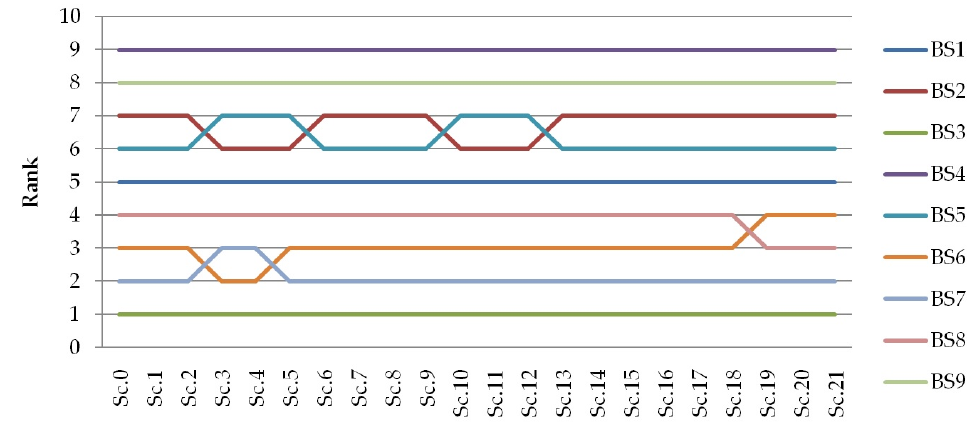
Figure 5. Sensitivity analysis. Based on the results of the sensitivity analysis, it can be seen that in all scenarios, the ranking of BS3 (ranked first), BS1 (ranked fifth), BS9 (ranked eighth) and BS4 (ranked ninth) were unchanged. Other BSs slightly changed their rank throughout the scenarios. BS7 ranked second in all scenarios except in Sc.3 and Sc.4. BS6 ranked third in most sce- narios. It changed rank to second in Sc.3 and Sc.4 and to fourth in Sc.19–21. BS8 ranked fourth in all but the last three scenarios. BS5 and BS2 alternately changed ranks between being sixth and seventh. In order to check how statistically significant the changes in the ranking of the alternatives in the scenarios were, SCC values were calculated for each scenario in comparison with the initial one (Table 11). In all scenarios, the values ranged between 0.967 and 1, and the average value for all scenarios was 0.991. These results proved that the obtained solution was very stable and could be adopted as the final